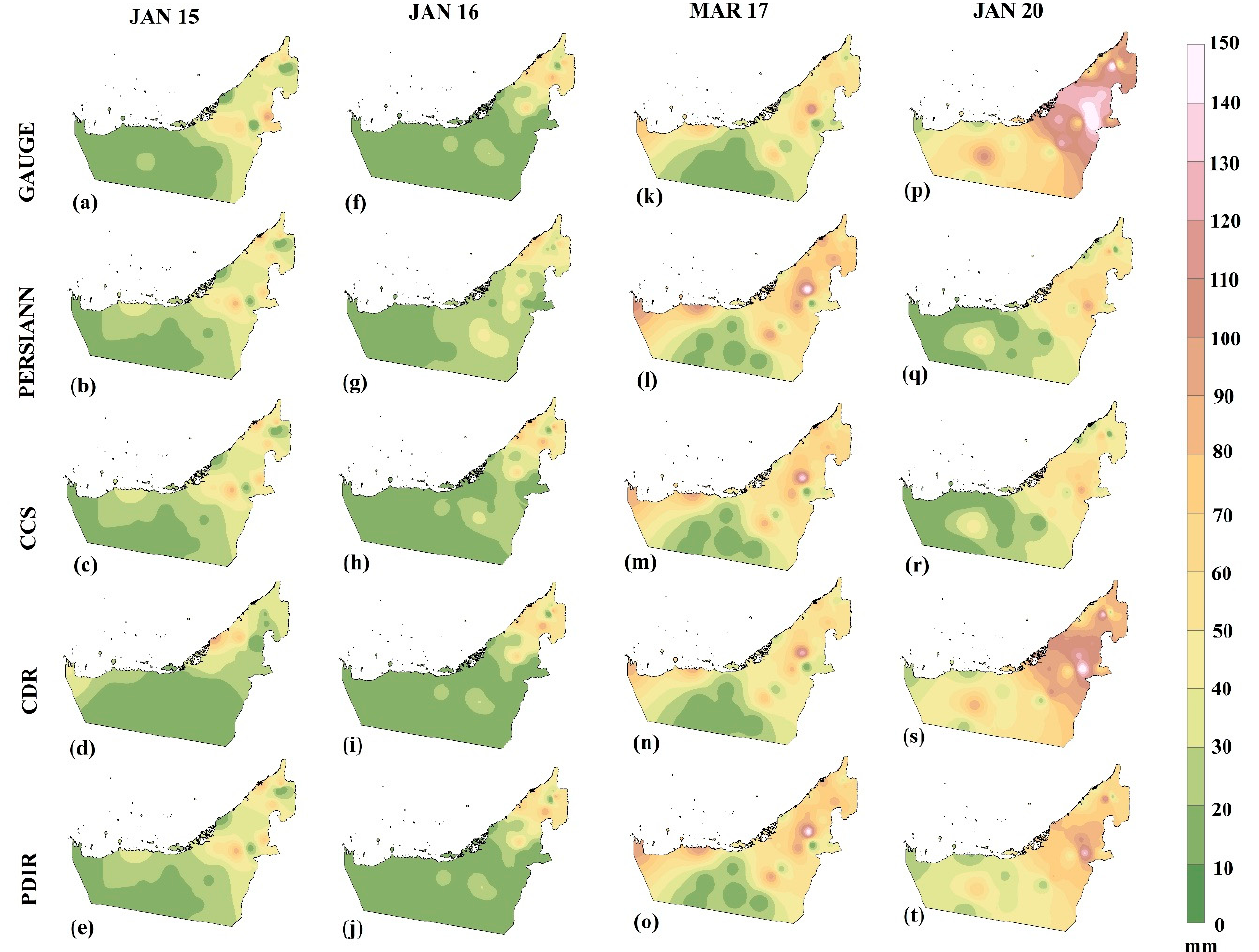
Figure 10. Comparison of satellite precipitation products with rain gauge observations for four selected rainfall events over the study area during the study period (2011–2020). Plots ( a – e ), ( f – j ), ( k – o ), and ( p – t ) represent the four events against each gauge and satellite products. The spatial plots were developed based on the maximum daily rainfall values from rain gauges.